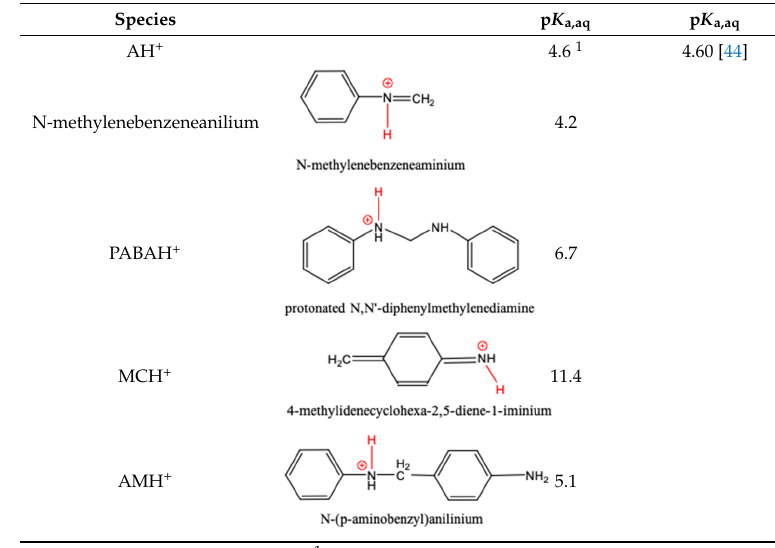
Table 3. Protonation dissociation constants (p K a,aq ) for the protonated intermediates in aqueous solution. The dissociative proton presented in red.